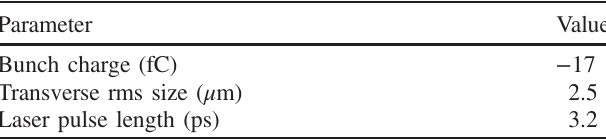
TABLE I. dc beam line simulation beam parameters.